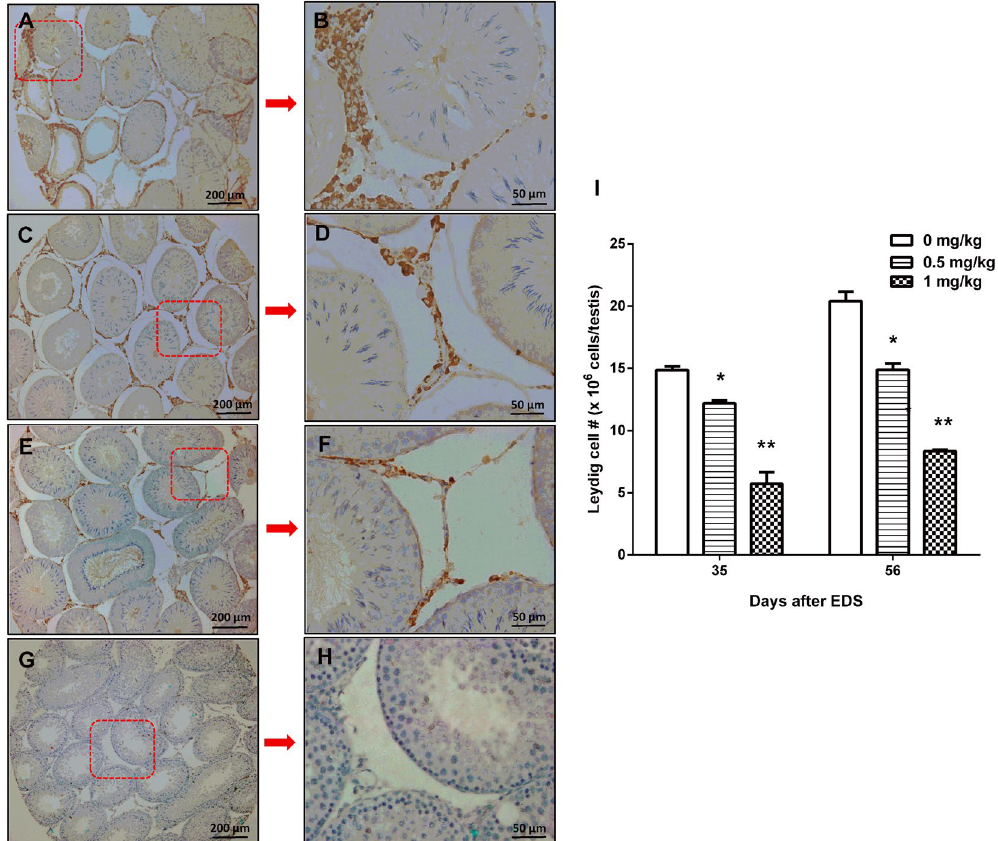
sections on days 35 and 56 after EDS treatment. ( A ) and ( B ) for control on days 35 and 56; ( C ) and ( D ) for 0.5 mg/kg CdCl on days 35 and 56; ( E ) and ( F ) for 1.0 mg/kg CdCl on days 35 and 56; ( G ) and ( H ) for the negative control. ( I ) Quantification of 11 β -HSD1 positive Leydig cell numbers on days 35 and 56. Mean ± SE, n = 5. * P < 0.05, ** P < 0.01 indicate significant difference when compared to control (CON) at each time